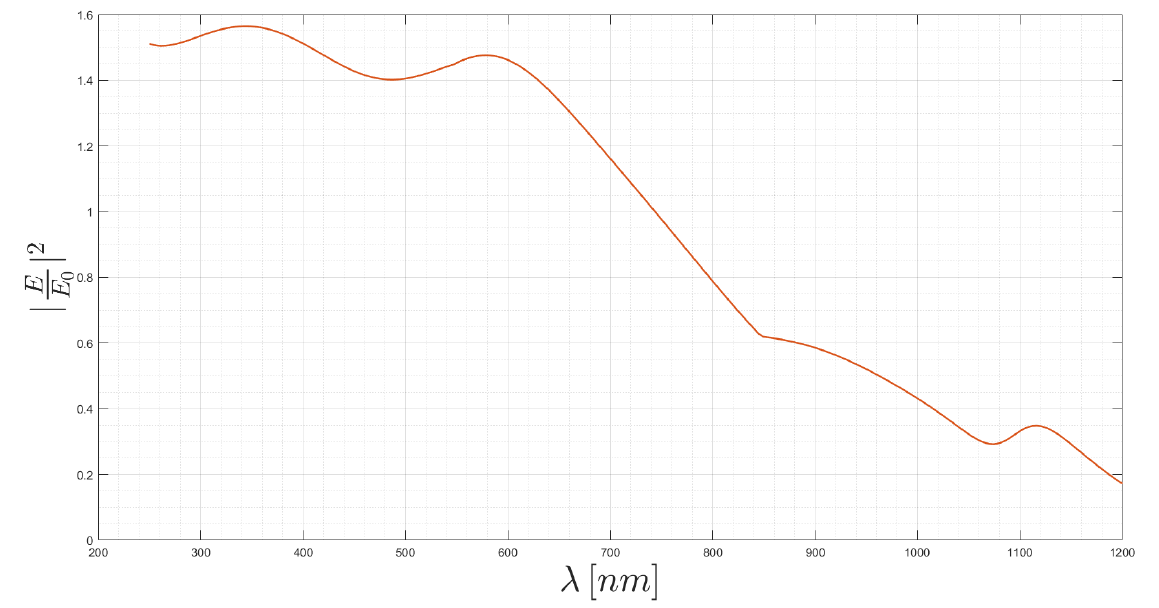
Figure 12. Optical response of an air–aluminum–quartz nanostructure characterized by a 0 = 0.3µm, d = 120nm, t = 50nm and t sub =